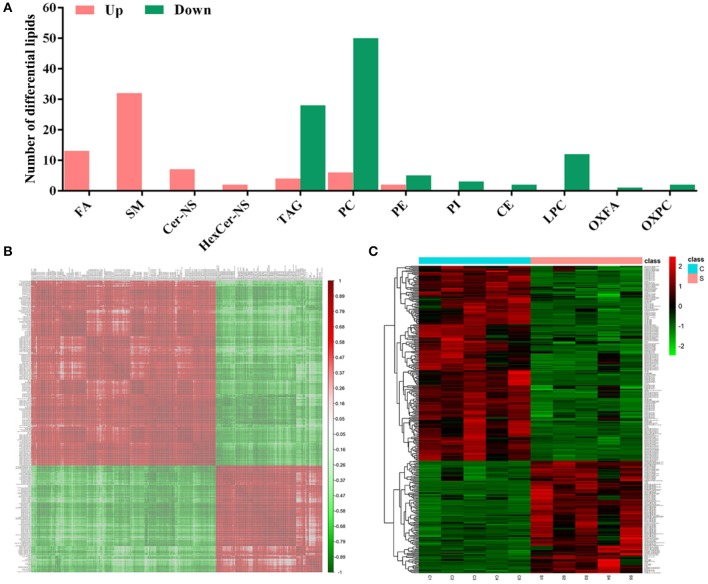
Differential metabolites between group S and group C. (A) Statistical analysis of differential metabolites between group S and group C. (B) Relevance matrix diagram of differential metabolites between group S and Group C. (C) Heat map of differential metabolites in Group S and Group C.